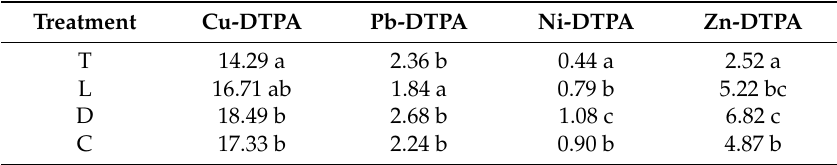
Table 4. Bioavailable concentrations of Cu, Pb, Ni, and Zi in soil (mg kg − 1 d.w.) Treatment